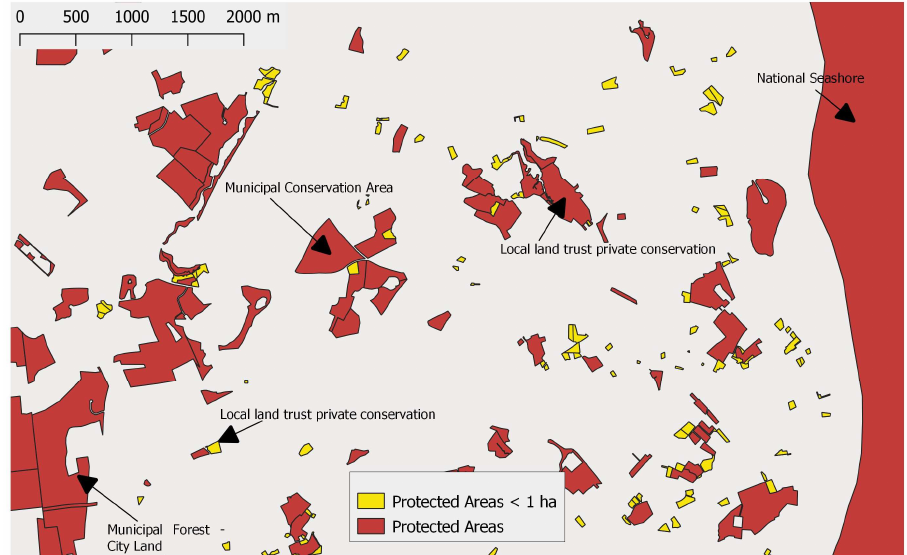
Figure 3. A portion of Cape Cod, USA, showing extremely small conserved parcels <1 ha, in yellow, in a matrix of slightly larger projects typical of those discussed in this paper. A selection of parcels is labeled to show the types of conservation lands in this landscape. Even the <1 ha areas have “conservation” designations in the database, i.e., are not data anomalies. To what extent small protected areas perform landscape-level biodiversity functions is largely unknown. QGIS V 3.2.